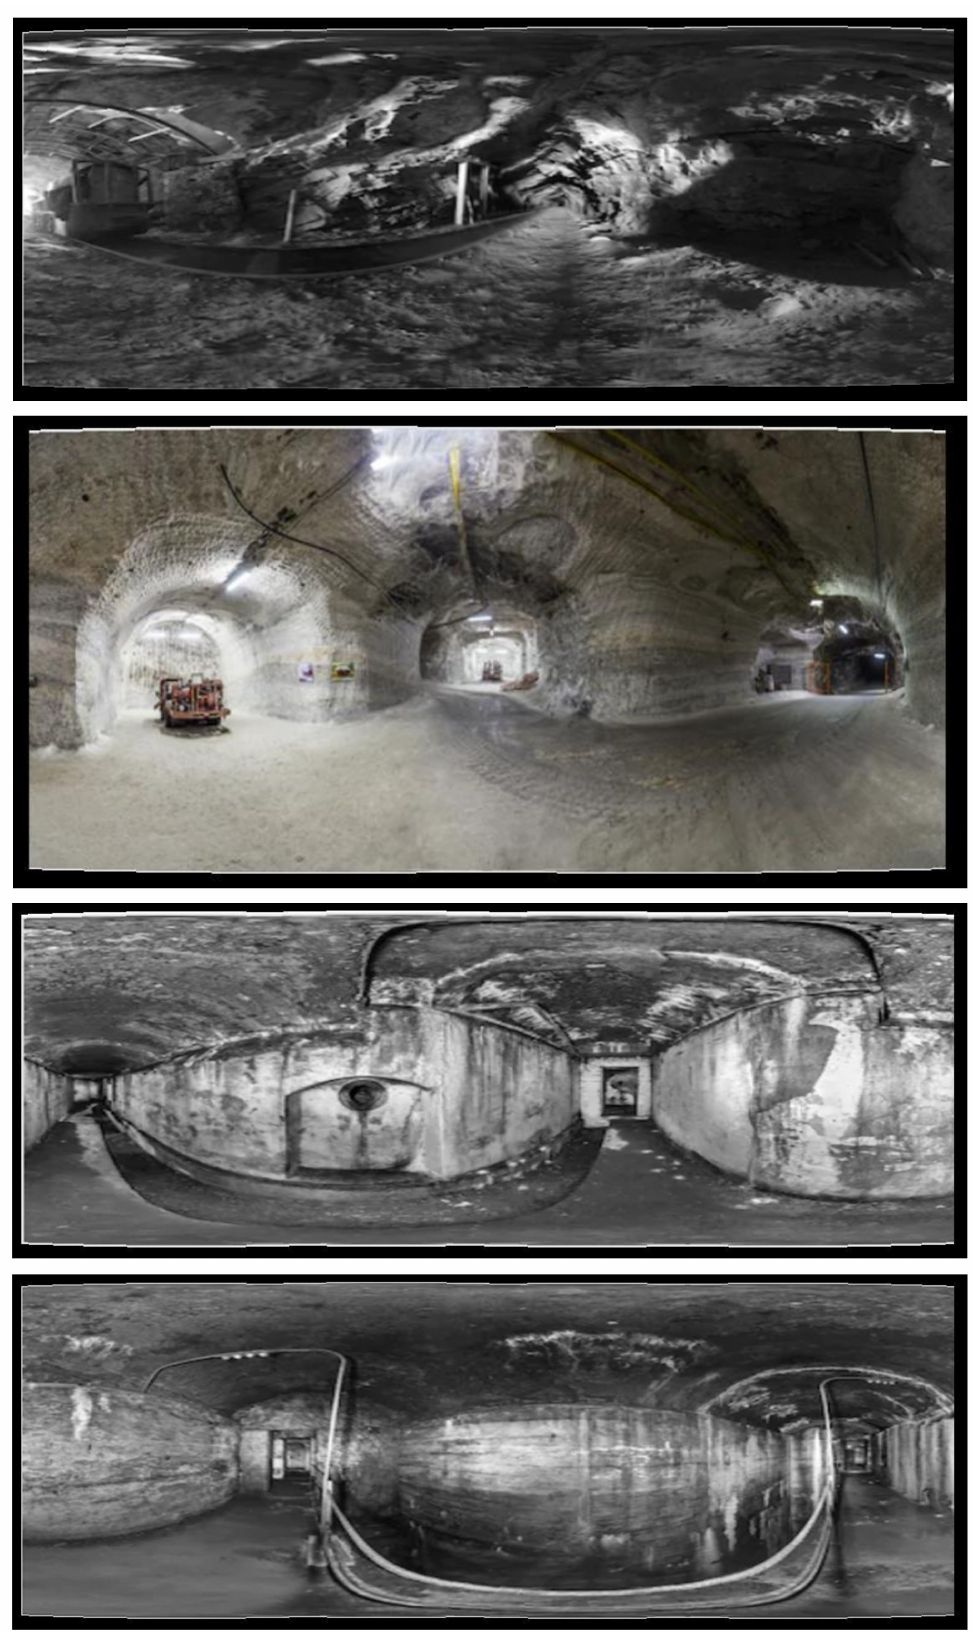
Figure 6. Example of generated panoramas of underground tunnel